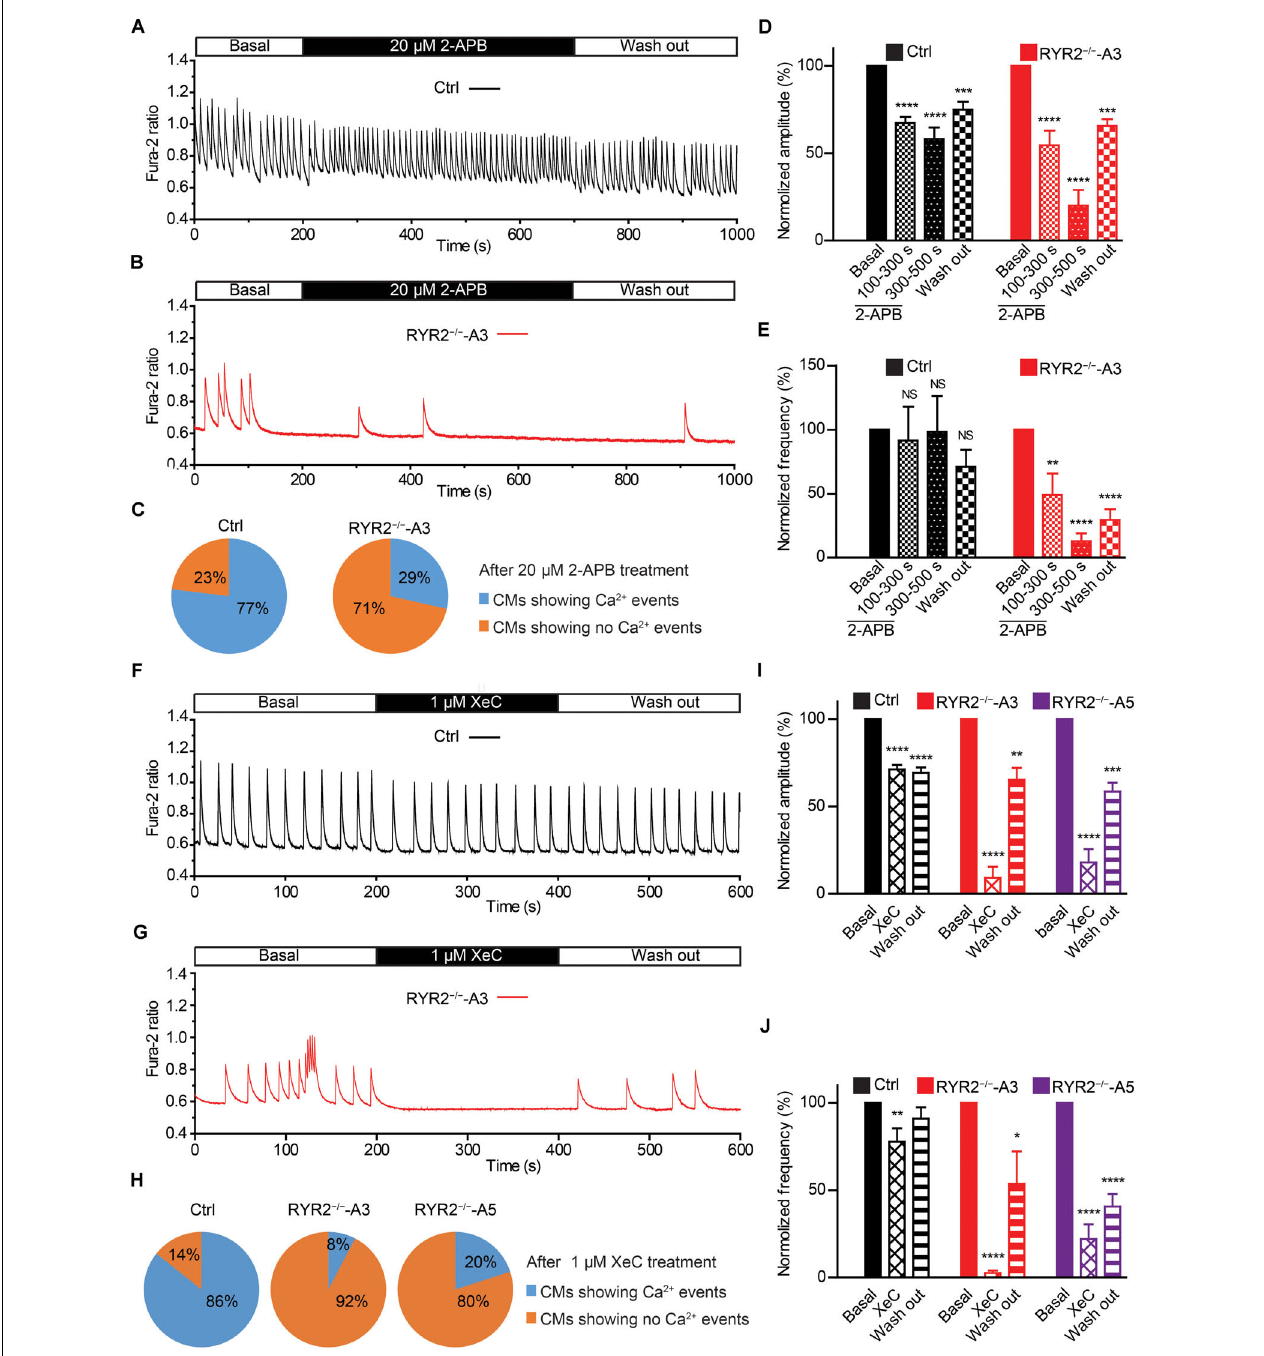
FIGURE 7 | Contributions of IP3R-mediated Ca 2 + release to spontaneous Ca 2 + transients in Ctrl- and RYR2 − / − -iPSC-CMs. (A,B) Representative cytosolic Ca 2 + dynamics in Ctrl- (A) and RYR2 − / − -iPSC-CMs (B) before and after the addition of IP3R antagonist 2-APB (20 µ M), and after the washout of the drug. (C) Pie charts depict the percentage of cells maintaining Ca 2 + transients after the treatment with 2-APB for 500 s. (D,E) Changes of Ca 2 + transient amplitude (D) and frequency (E) after the treatment and the following removal of 2-APB, which were normalized to those from the same cell under the basal condition (Ctrl: n = 13 cells from three differentiation experiments; A3 RYR2 − / − : n = 14 cells from three differentiation experiments). (F,G) Representative cytosolic Ca 2 + dynamics in Ctrl- (F) and RYR2 − / − -iPSC-CMs (G) before and after the addition of IP3R inhibitor Xestospongin C (XeC;1 µ M), and after the washout of the drug. (H) Pie charts depict the percentage of cells maintaining Ca 2 + transients after the treatment with XeC for 200 s. (I,J) Changes of Ca 2 + transient amplitude (I) and frequency (J) after the treatment and following the washout of XeC, which were normalized to those from the same cell under the basal condition (Ctrl: n = 14 cells from three differentiation experiments; A3 RYR2 − / − : n = 13 cells from three differentiation experiments; A5 RYR2 − / − : n = 10 cells from two differentiation experiments). * P < 0.05; ** P < 0.01; *** P < 0.001;**** P < 0.0001 by using the one-way ANOVA with the Dunnett’s multiple comparison test.